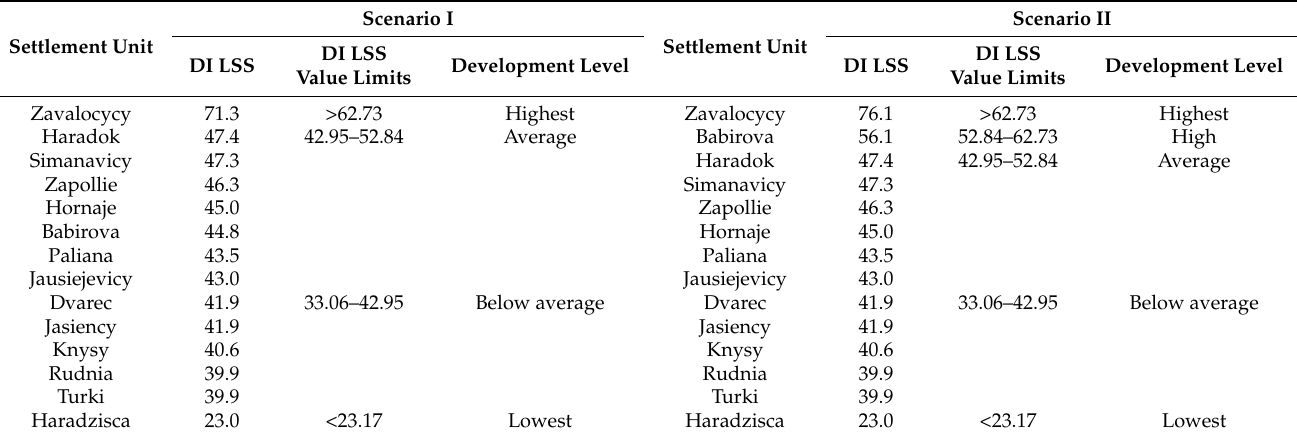
Table 4. Monitoring Results for Local Settlement System (Zavalocycy Local Council). Source: Own